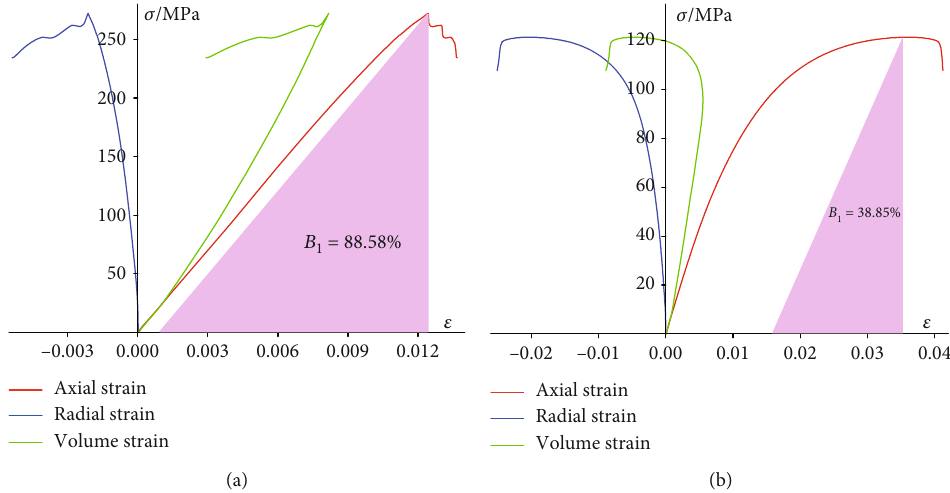
Figure 3: Typical stress-strain curves of higher and lower brittle rocks.